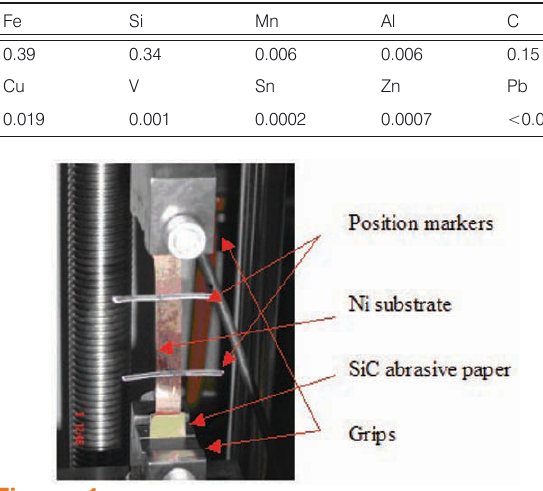
Figure 1. Tensile strength test arrangement for thin metal tapes.